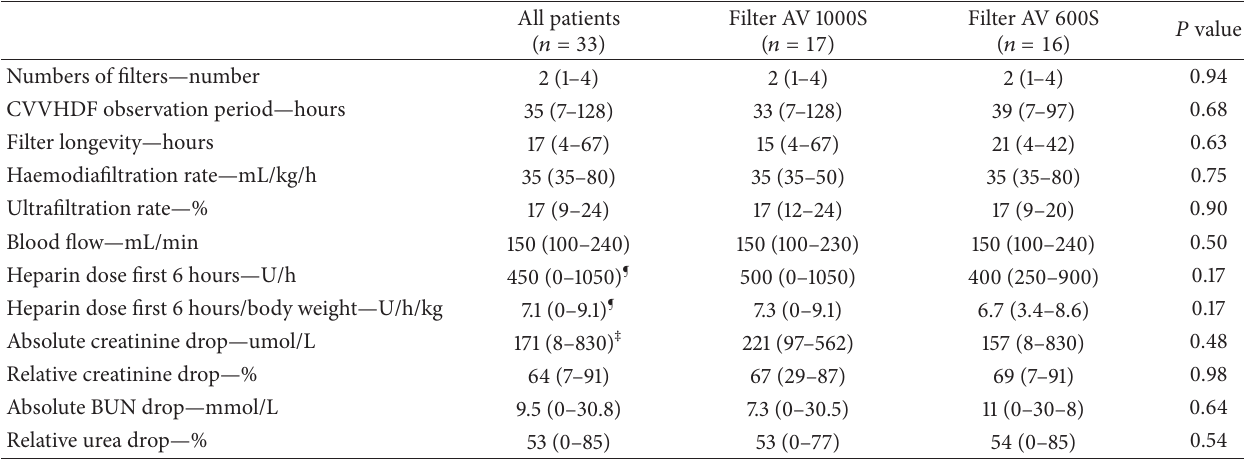
Table 2: Filter longevity and CVVHDF setting. All